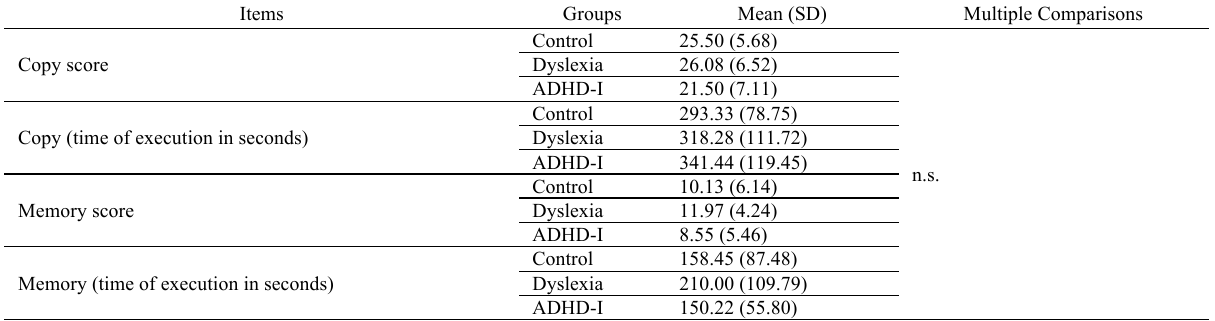
Table 13 – Means and standard deviations: Rey Complex Figure Test.